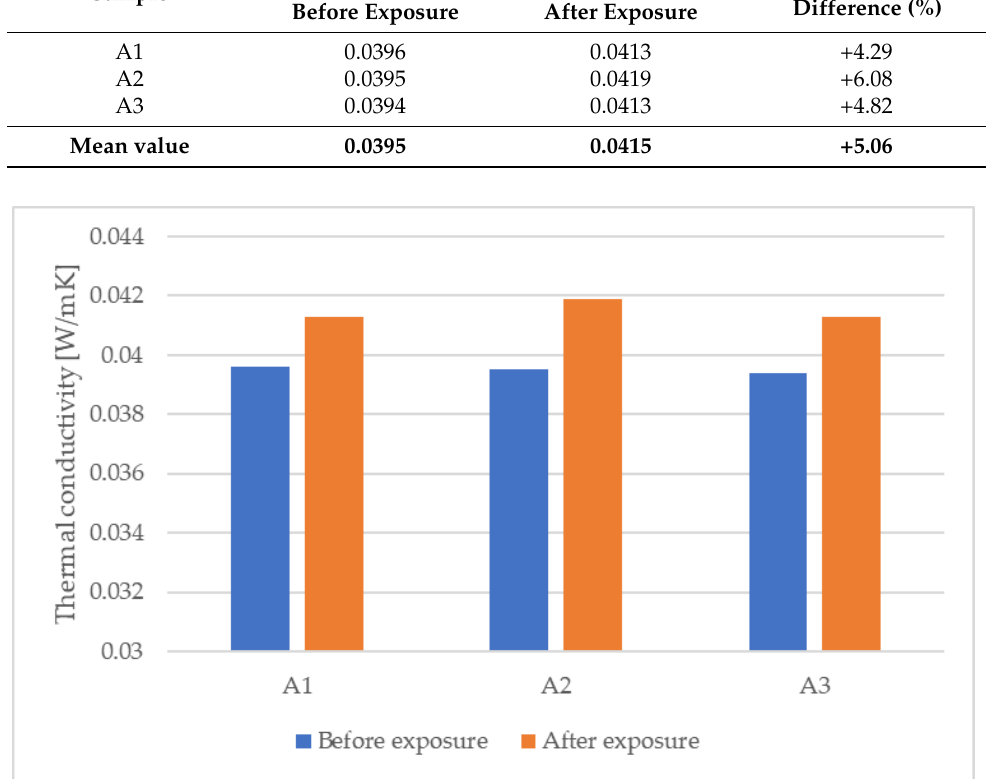
Figure 5. Graphic representation of the variation of the thermal conductivity. The increase in thermal conductivity of the analyzed material was, on average, 5.06%, with a direct impact on the thermal performance of the building elements. To quantitatively establish this influence, calculations of heat loss by conduction were performed for nine elements according to Equation (1).